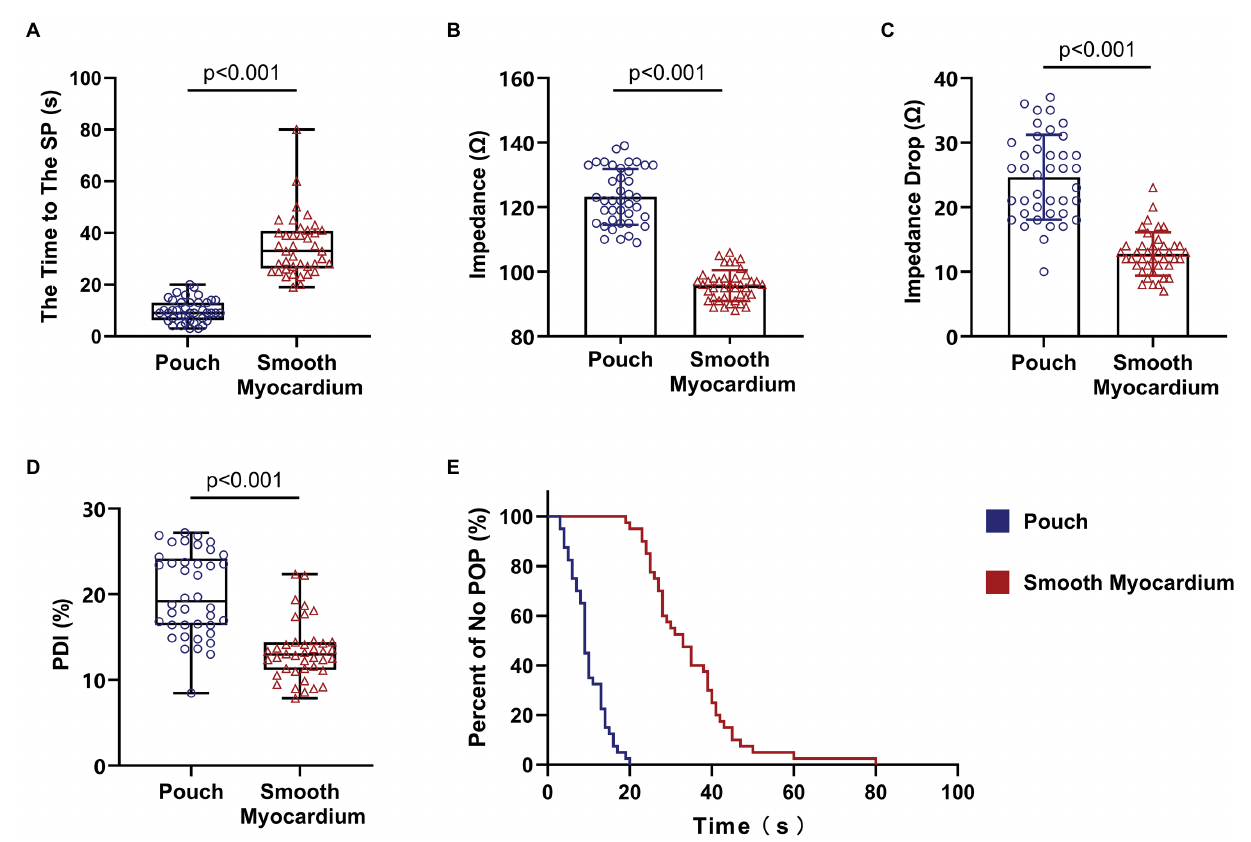
FIGURE 3 | Steam pops occurred earlier in the pouch group. Impedance of the pouch tissue was high and rapidly decreased at the beginning of RFA. (A) RFA duration before SPs was shorter in the pouch group compared to the smooth myocardium group. (B) Impedance was higher in the pouch group compared to the smooth myocardium group. (C) Decrease in impedance in the first 3 s of RFA was faster in the pouch group compared to the smooth myocardium group. (D) The PDI of the pouch group was greater than that of the smooth myocardium group. (E) Kaplan–Meier curves show that SPs occurred earlier in the pouch group compared to the smooth myocardium group. PDI, percentage of delta